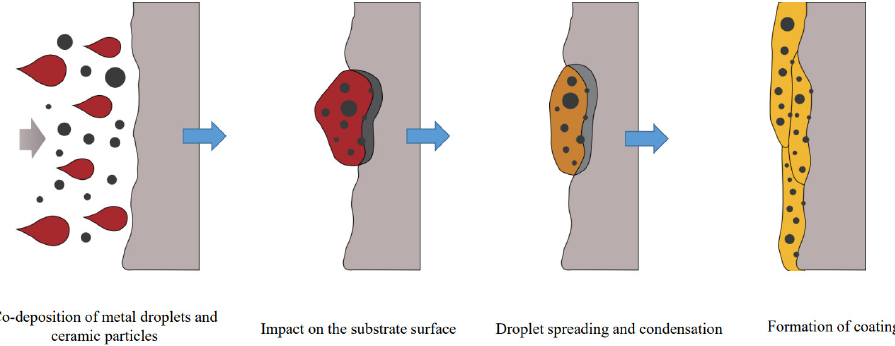
Figure 6. Schematic diagram of the deposition process of the coating.